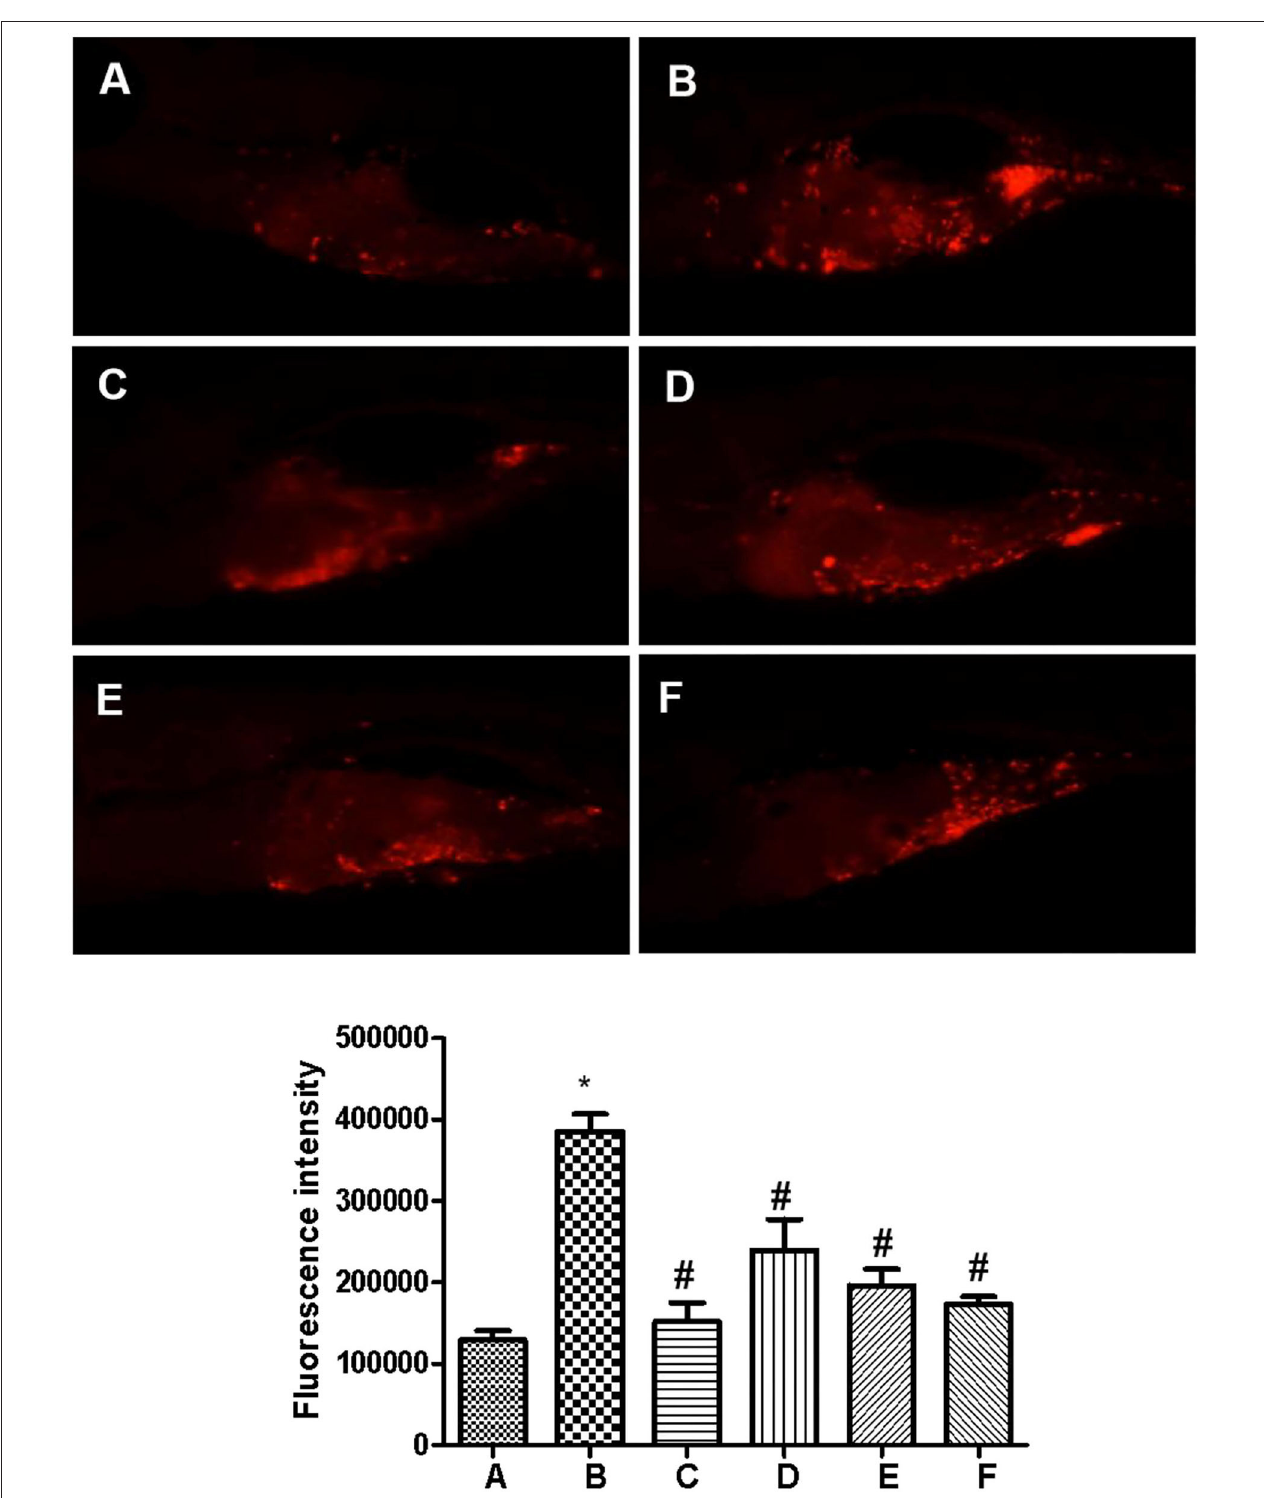
FIGURE 2 | Sea cucumber intestinal peptide inhibits the growth of tumor cells in zebrafish. The wild-type AB zebrafish do not produce red fluorescence. CM-Dil labeled cells injected into the yolk sac of zebrafish can produce red fluorescence at a certain wavelength. The total fluorescence intensity is positively correlated with the number of cancer cells. (A) Control group; (B) Model group; (C) Capecitabine group, administration of 20 µ g/ml capecitabine by water-soluble; (D) Low concentration SCIP group, administration of 27.8 µ g/ml SCIP by water-soluble; (E) Middle concentration SCIP group, administration of 83.3 µ g/ml SCIP by water-soluble; (F) High concentration SCIP group, administration of 250 µ g/ml SCIP by water-soluble. “*” means that the experimental group was significant. On the contrary, the “#” means that the experimental group is not significant.